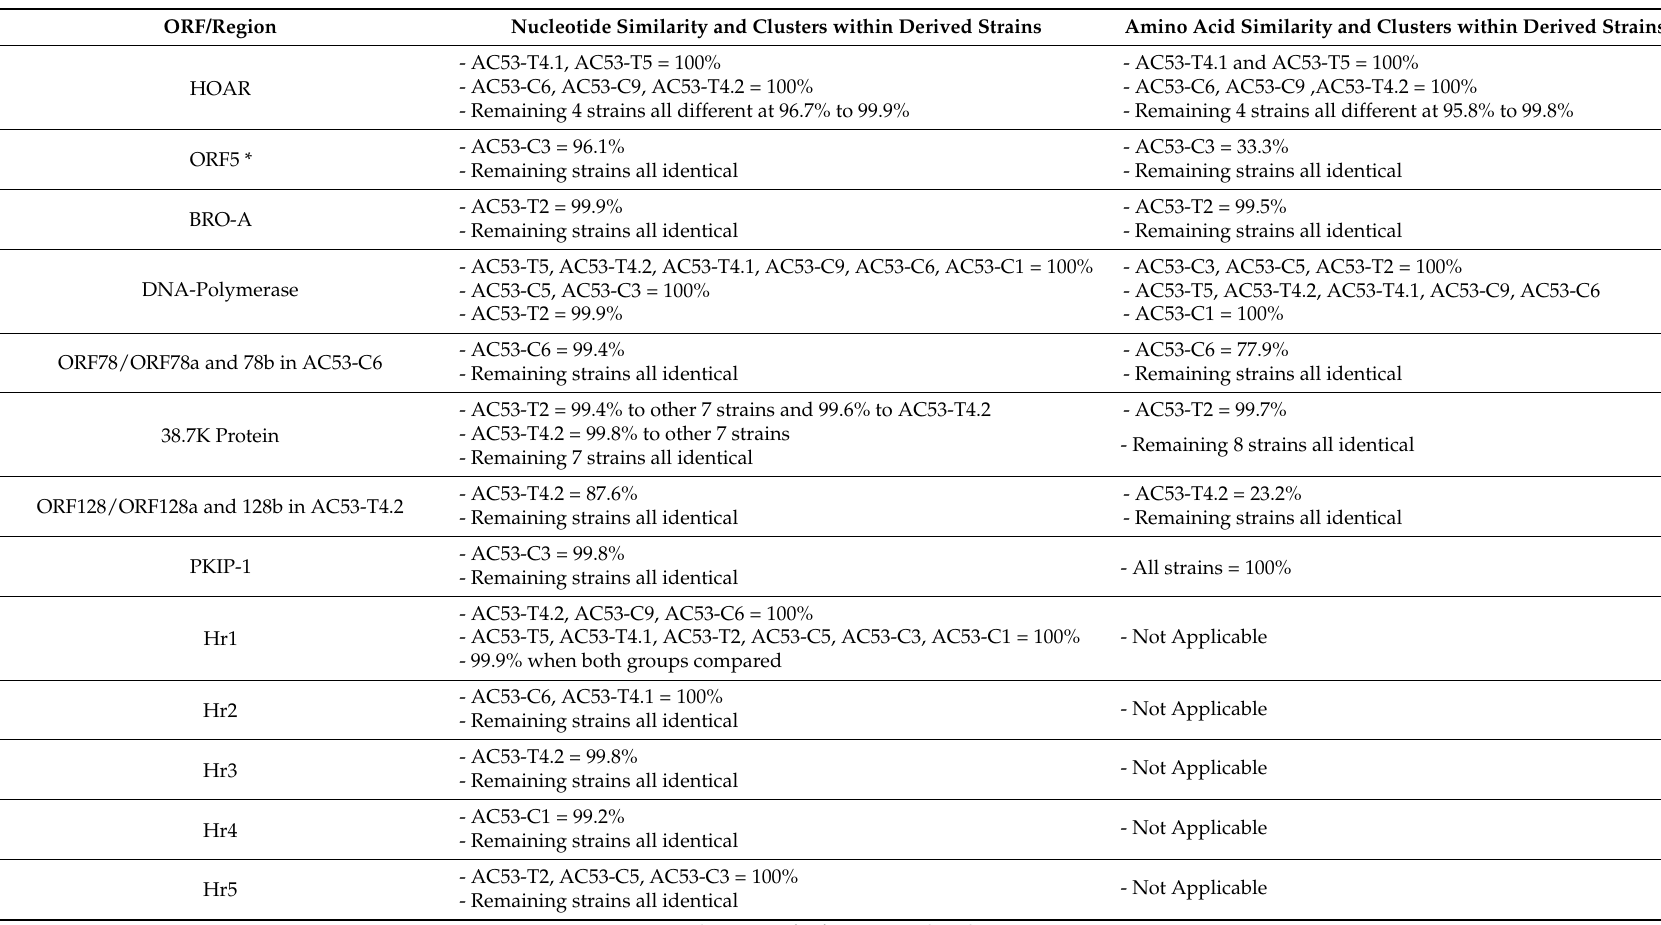
Table 4. Comparison of the nucleotide and amino acid sequence similarity of AC53 derived strains to each other. The greatest diversity was within the five homologous repeat regions, DNA polymerase and HOAR. Only AC53-T2 contained an amino acid difference in BRO-A. ORF5 is shorter in length in all strains except AC53-C3 than in AC53. AC53-C6 and AC53-T4.2 contained unique mutations within ORF78 and ORF128, respectively, due to an inserted